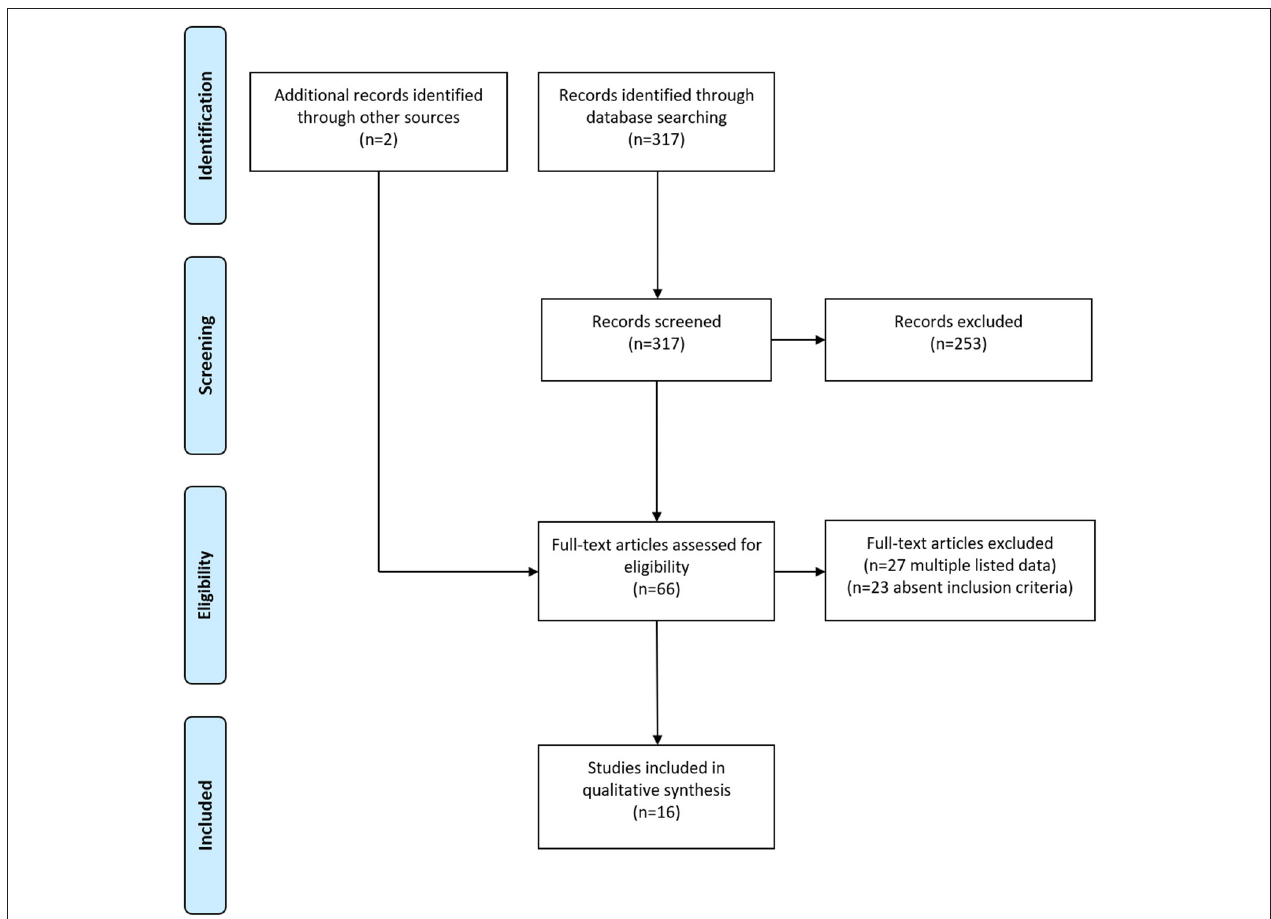
FIGURE 1 | Flow diagram illustrating study identification